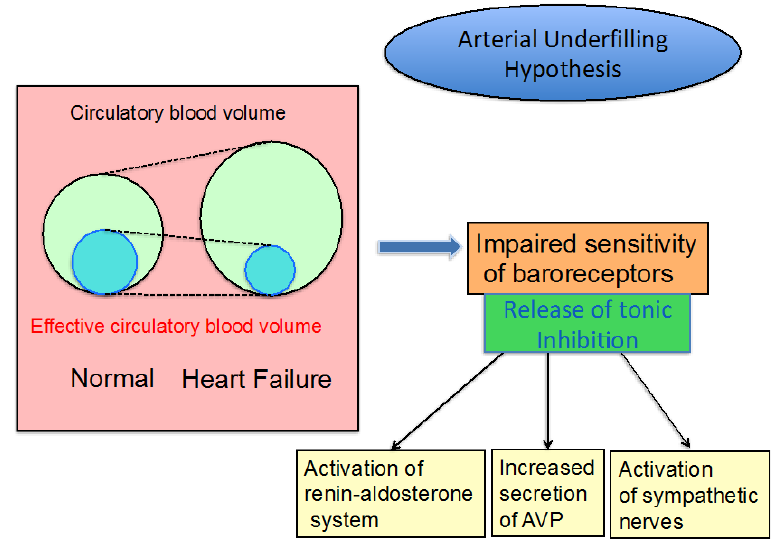
Figure 2. Hypothesis for dysregulation of baroreceptor-mediated hormonal release in congestive heart failure.